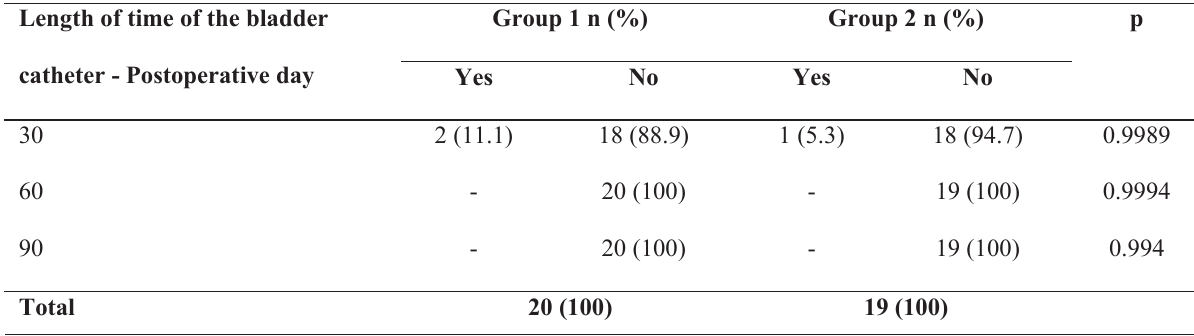
Table 2 – Postoperative spontaneous void after sling surgery for the treatment of stress Table 1 - Length of time of indwelling bladder catheter after sling procedure for urinary treatment of SUI.